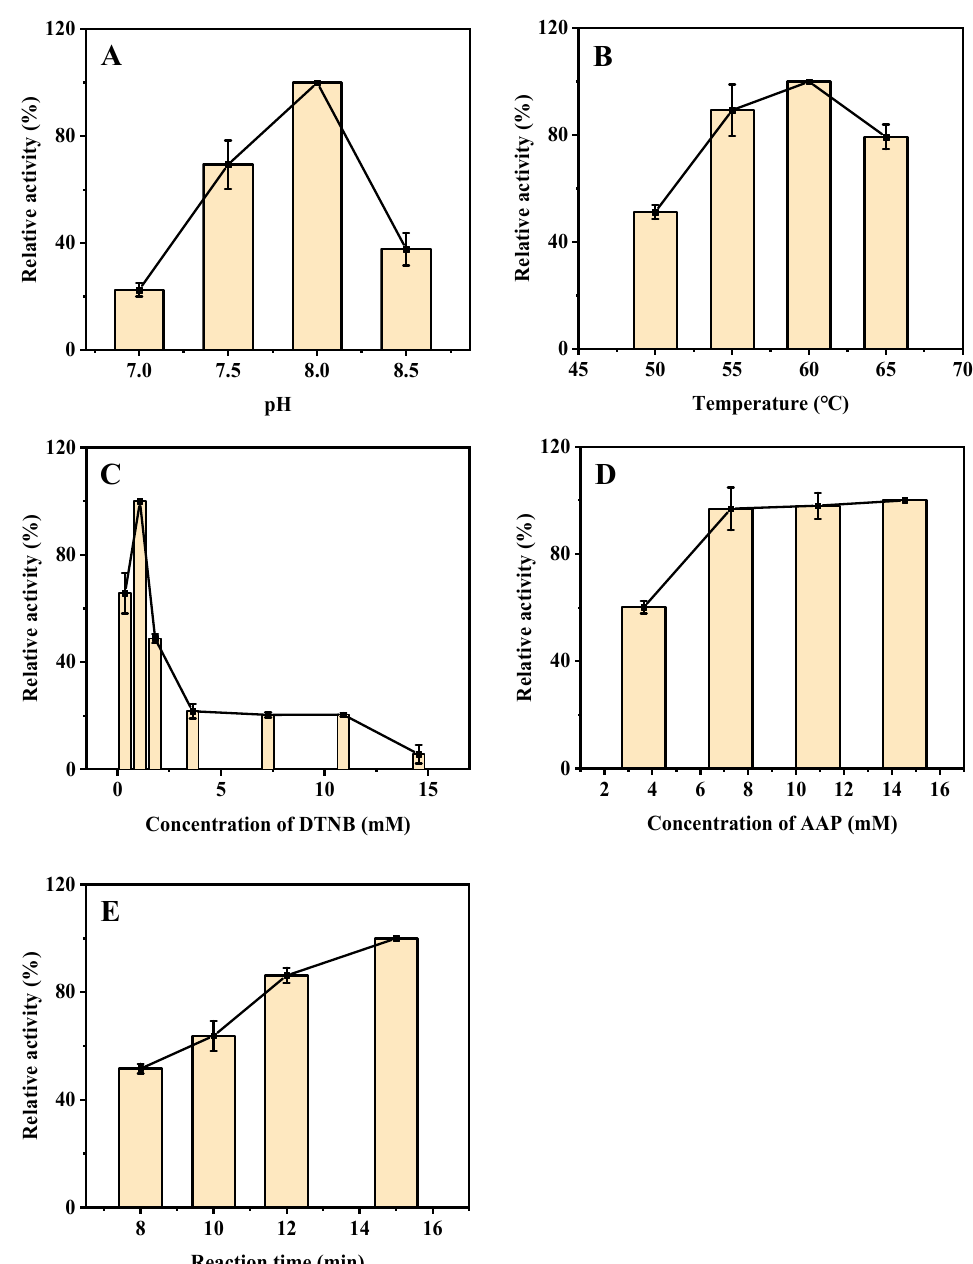
Figure 4. Effects of buffer pH ( A ), incubation temperature ( B ), concentration of DTNB ( C ) and AAP ( D ), and reaction time ( E ) on the ALP-like activity of ZIF-8 for the detection of Cu 2+ and AAO. Buffer pH, 8.0 for B – E ; ZIF-8, 4 mg for A – E ; DTNB, 7.3 mM for A , B , D , E ; incubation temperature, 60 °C for A , C – E ; AAP, 14.5 mM for A – C , 7.3 mM for and E; reaction time, 8 min for A – D ; centrifugation time, 3 min for A – E .